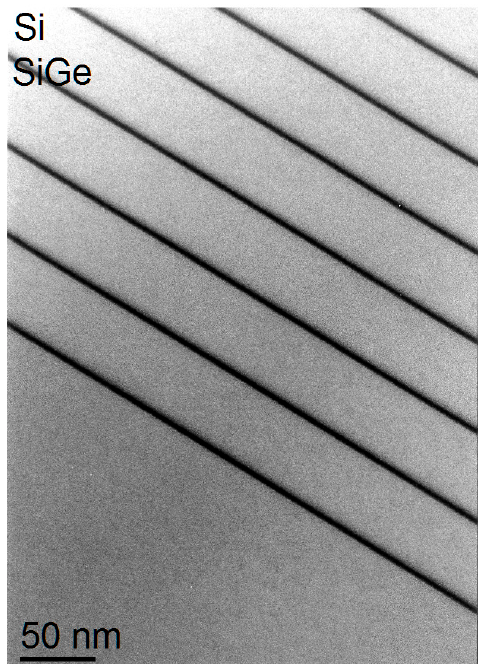
Figure 5. Ge surface segregation in a Si/SiGe multiple quantum well with 49 nm period length. BF TEM. Note lower interfaces appear sharp while upper interfaces are slightly blurred, proving Ge surface segregation qualitatively.